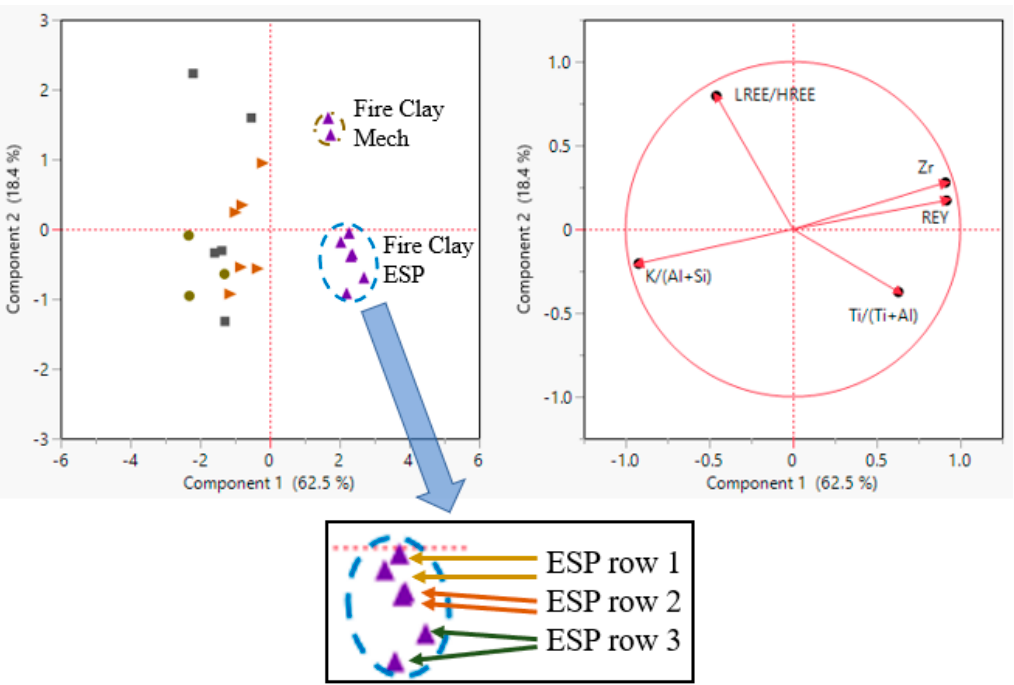
Figure 2. Plot of principal component analysis axes ( right ) and individual points ( left ). The inset shows the detail of the Fire Clay source (93953–93960) series 3 ESP data. The detailed key to the symbols is on Table S1.